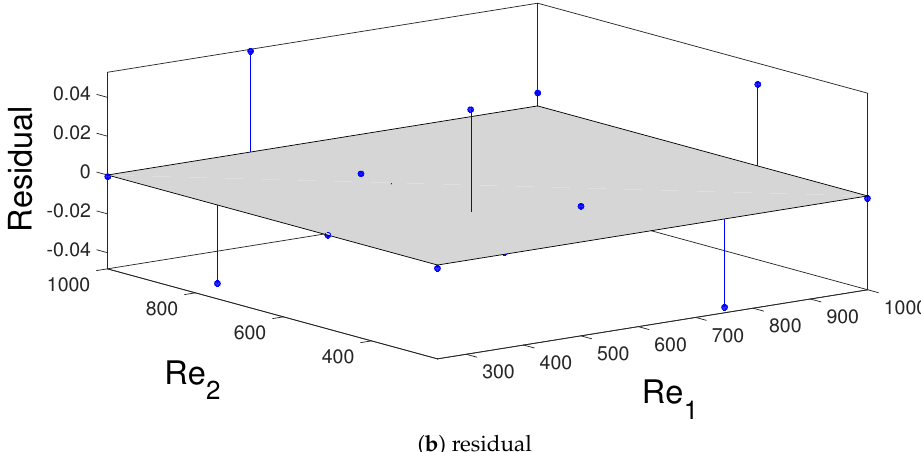
Figure 17. Contour plot ( a ) and residual ( b ) obtained with the polynomial fit for the efficiency of the TEG device with varying jet stream Reynolds numbers at φ =